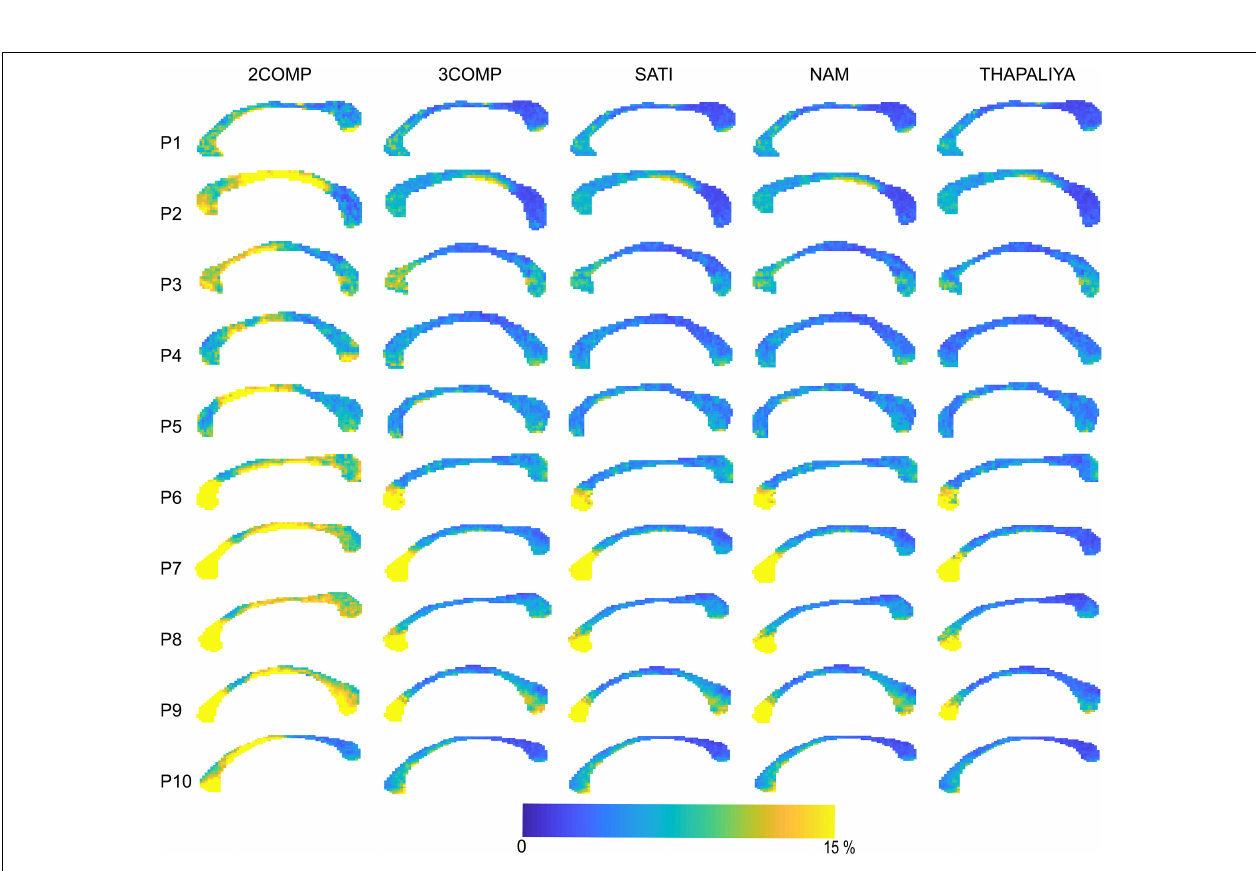
FIGURE 5 | Maps of the model fitting error for the models considered. The fitting error is larger for the two-signal compartment model (2COMP) model, which has two compartments, in comparison with all three-compartment models (3COMP, Sati, Nam, and Thapaliya).